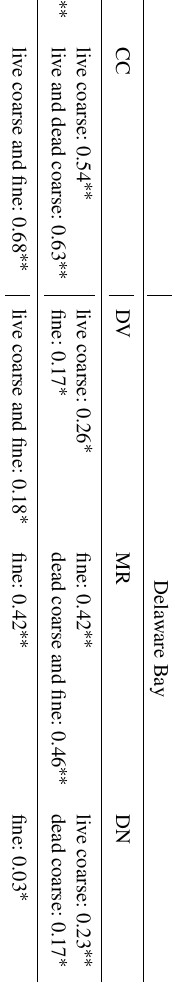
Figure 2. Belowground ingrowth rate (a) and percent mass remain- ing in belowground litterbags (b) over a 20-month period in salt marshes of two mid-Atlantic estuaries ( n = 5, ± standard error).